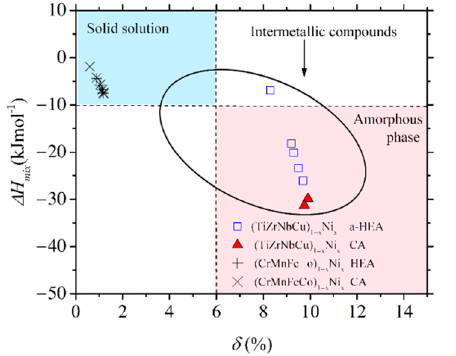
Figure 4. A plot of ∆ H mix vs. δ showing the data for (CrMnFeCo) 1 − x Ni x and (TiZrNbCu) 1 − x Ni x alloys. Data for conventional alloys (CAs) are denoted with different symbols. Black oval encompasses alloys comprising intermetallic compounds.